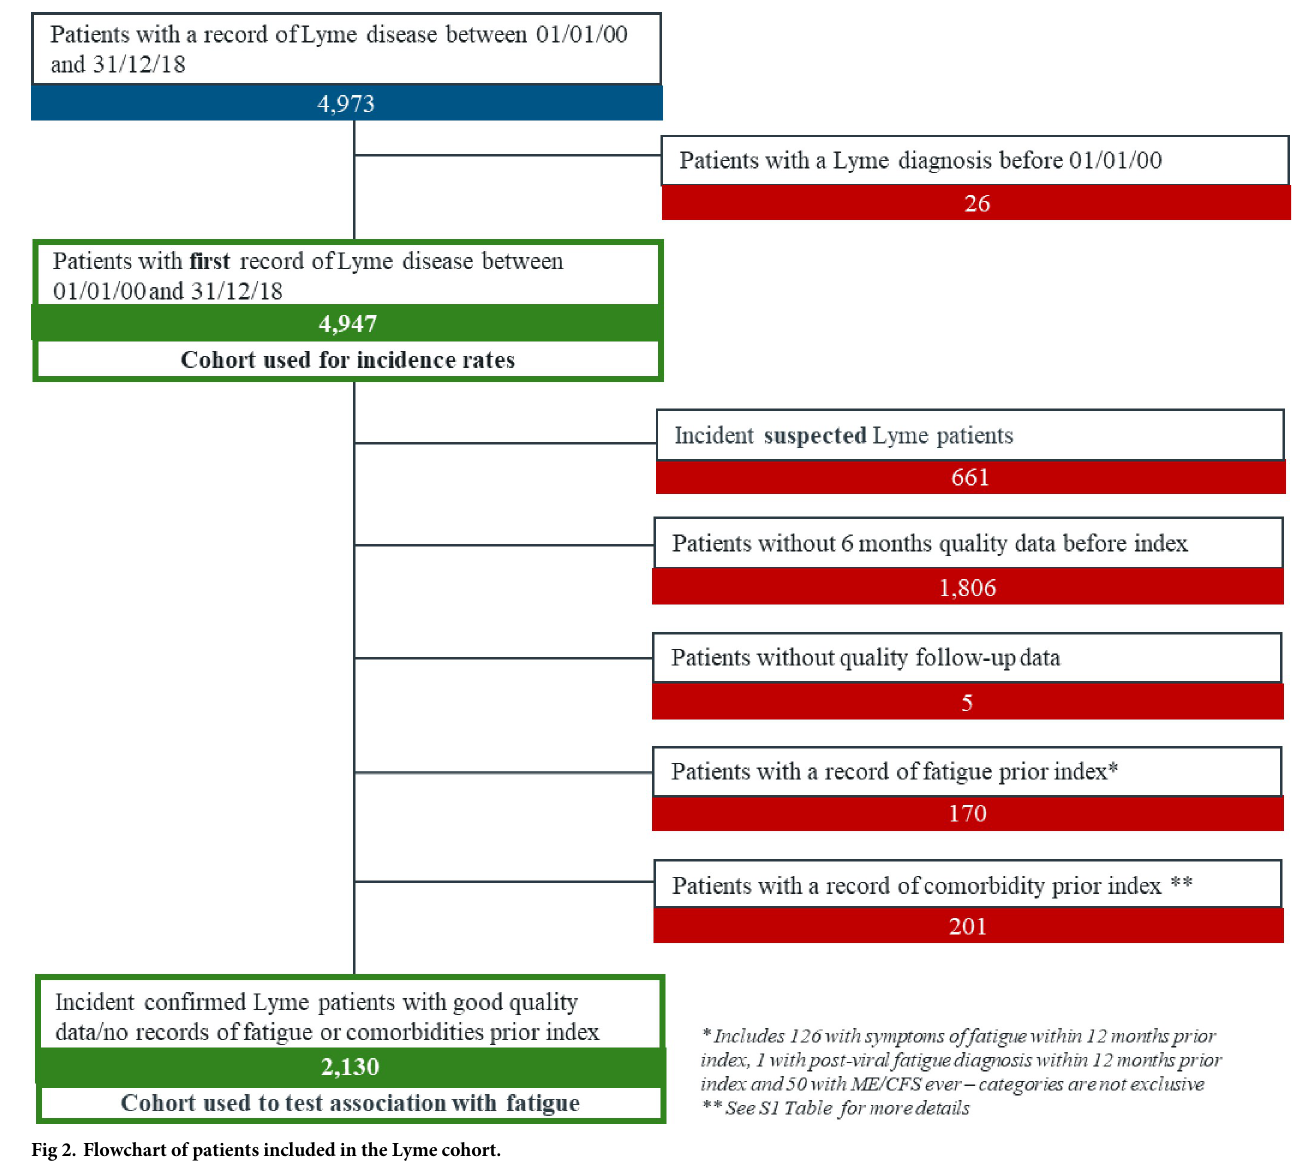
Fig 2. Flowchart of patients included in the Lyme